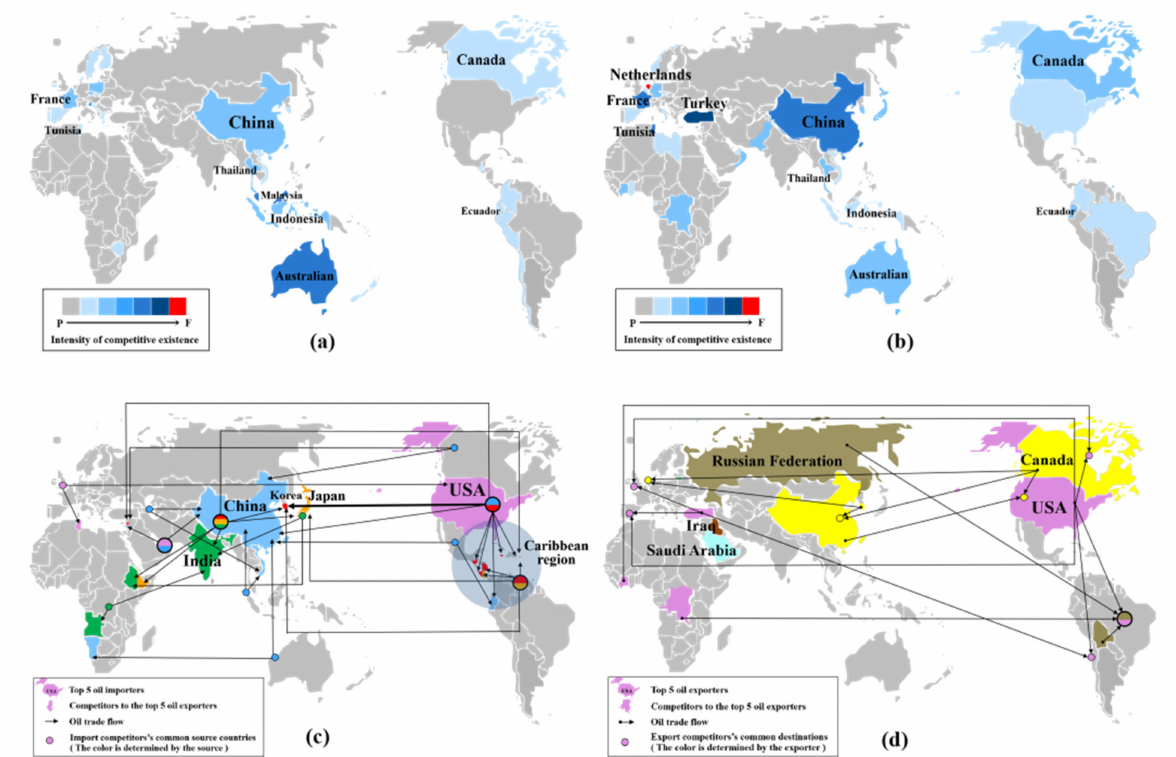
Figure 9. Increased competition among major importers and exporters, 2000–2019. ( a ) Import competition “stable” countries; ( b ) Export competition “stable” countries; ( c ) The top 5 importers with their competitions; ( d ) The top 5 exporters with their